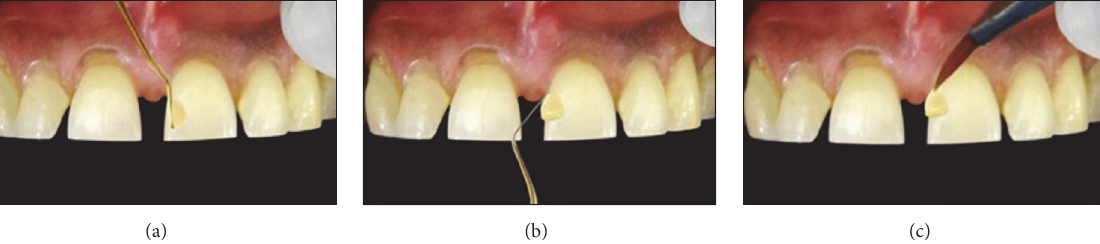
Figure 4: (a) A small increment of composite is taken. (b) This incrementis flattened with the instrument and is sculpted towards free gingival margin. (c) Composite is then thinned with a brush to achieve an imperceptible margin.